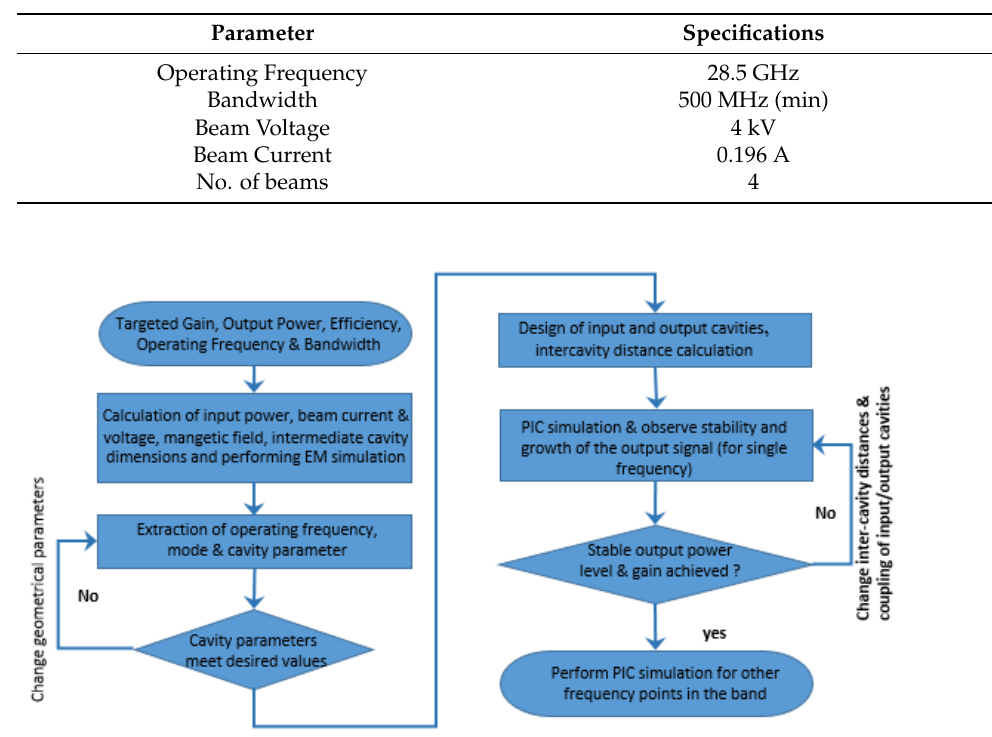
Figure 1. Flowchart of RF section design procedure.